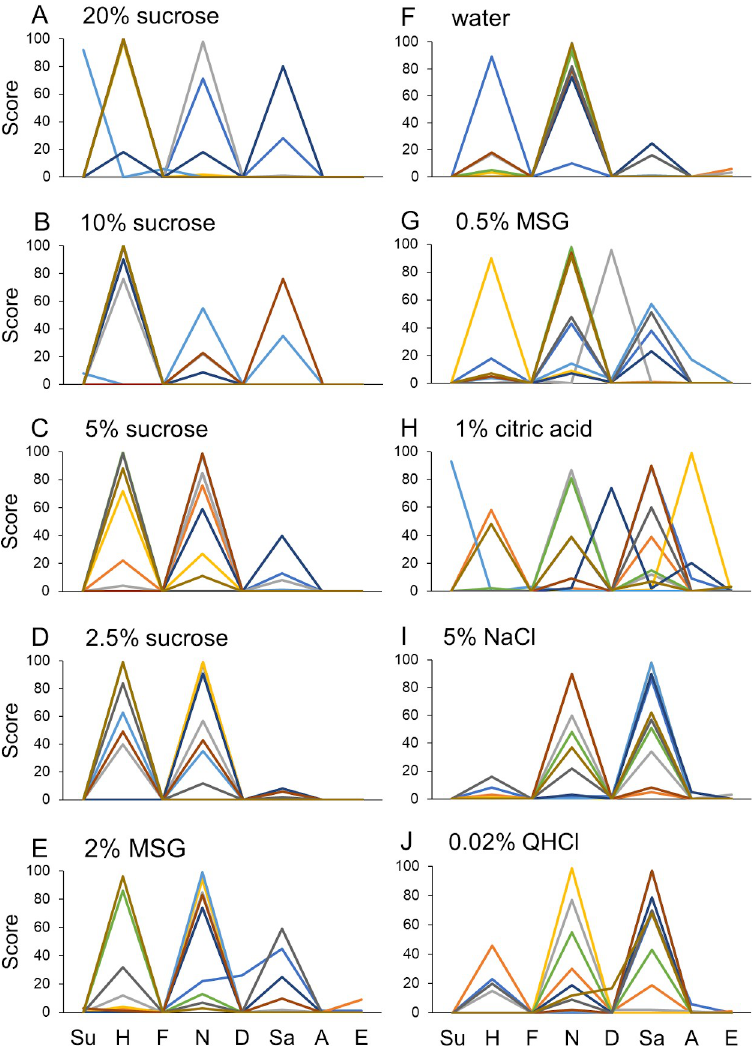
Fig 1. Profiles of hedonic patterns across eight different emotions based on Artificial Intelligence (AI) analysis of facial expressions in response to 10 stimuli in 10 participants. Profiles are depicted in different colors for the 10 participants. The emotions are arbitrarily arranged from left to right in the order of surprise (Su), happiness (H), fear (F), neutral (N), disgust (D), sadness (Sa), anger (A), and embarrassment (E).